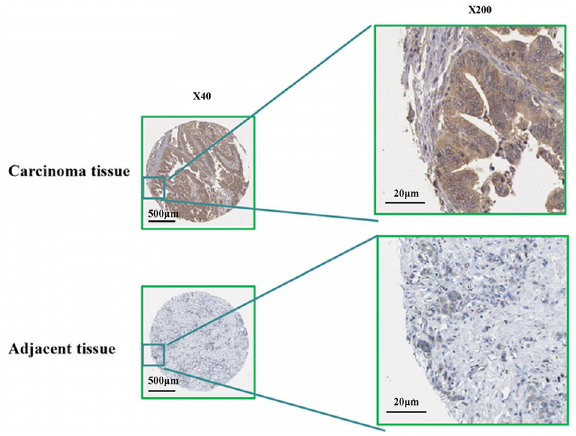
Figure 3. Immunohistochemical staining of RBM8A in gastric carcinoma samples and adjacent tissues. Bars: 500 m m and 20 m